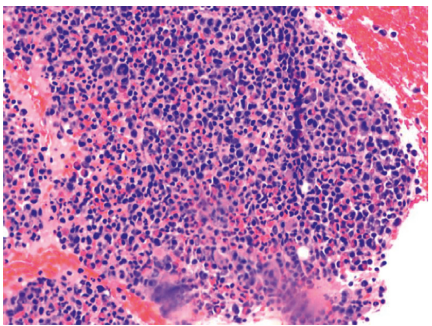
Figure 3: Clot section which shows hypercellularity and increased mast cells.